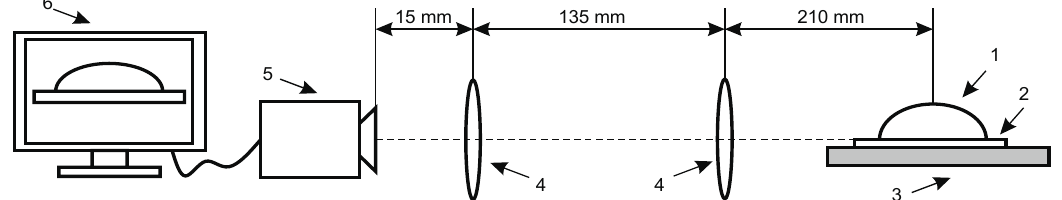
Figure 9. Experimental setup for contact angle measurement of hydrophobic and hydrophilic material: 1, drop on the specimen; 2, analyzed coating; 3, specimen; 4, double convex lenses; 5, Guppy F-503 B&W CMOS camera; 6, computer system for analysis of the captured image.